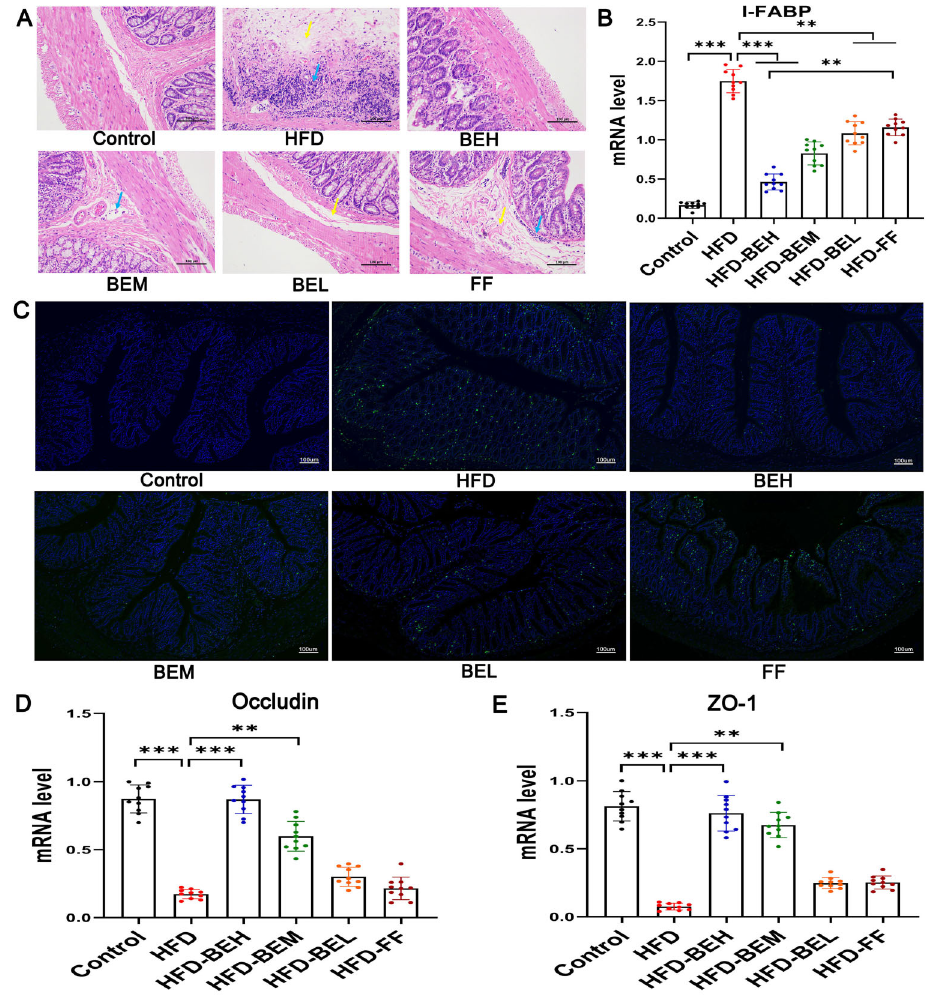
Figure 5. Effect of berberine and evodiamine (BE) at high, medium, and low doses (BEH, BEM, BEL) or feno fi brate (FF) on intestinal integrity of animals fed a high-fat diet (HFD). A , Hematoxylin and eosin (HE) staining of ileum tissues (magni fi cation: 200 (cid:2) , scale bar: 100 m m). The blue arrows indicate lymphocyte in fi ltration, and the yellow arrows indicate submucosa edema. B , mRNA expression of intestine fatty acid binding protein (I-FABP) by qRT-PCR. C , Immuno fl uorescence images of terminal deoxynucleotidyl transferase- mediated nick end labeling (TUNEL) (green fl uorescence) as an indicator of apoptosis of ileum epithelial cells (magni fi cation: 10 (cid:2) , scale bar: 100 m m). D , mRNA expression of occludin and ( E ) zonula occludens-1 (ZO-1) by qRT-PCR. Data are reported as means ± SD. **P o 0.01; ***P o 0.001 (one-way